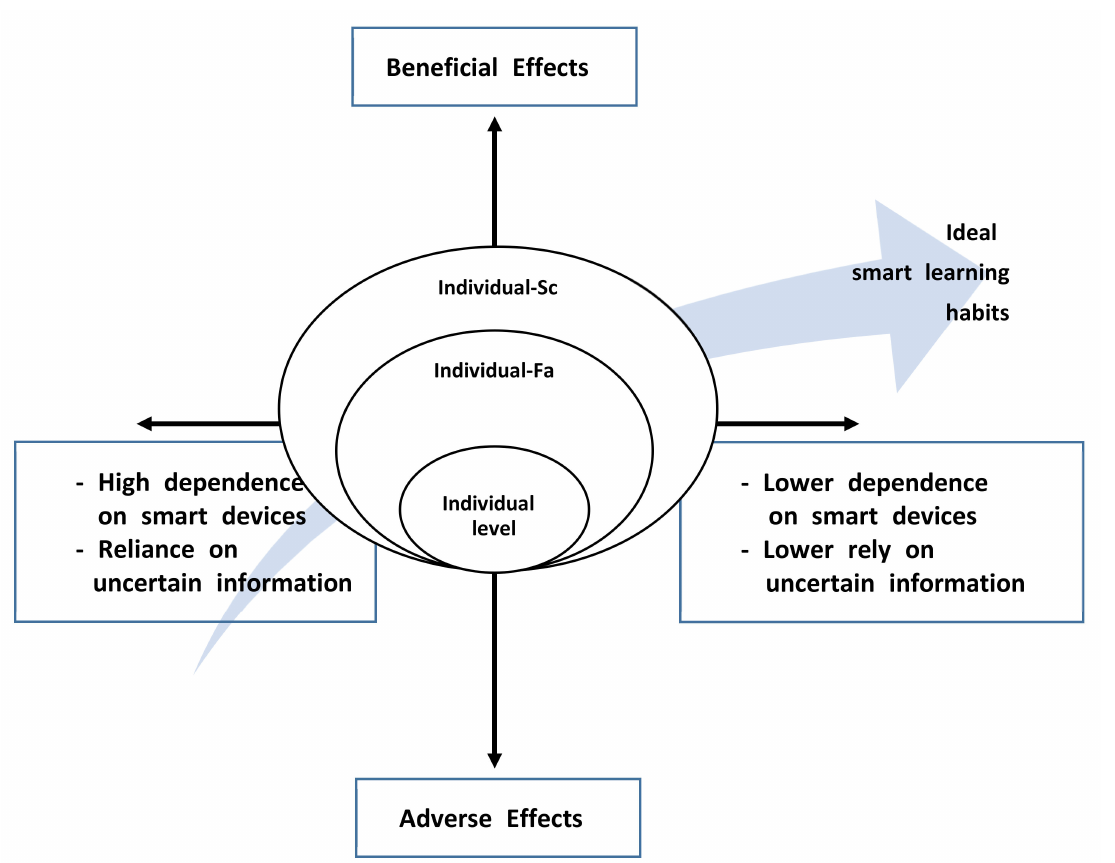
Figure 2. A model for ideal digital habits with the use of smart